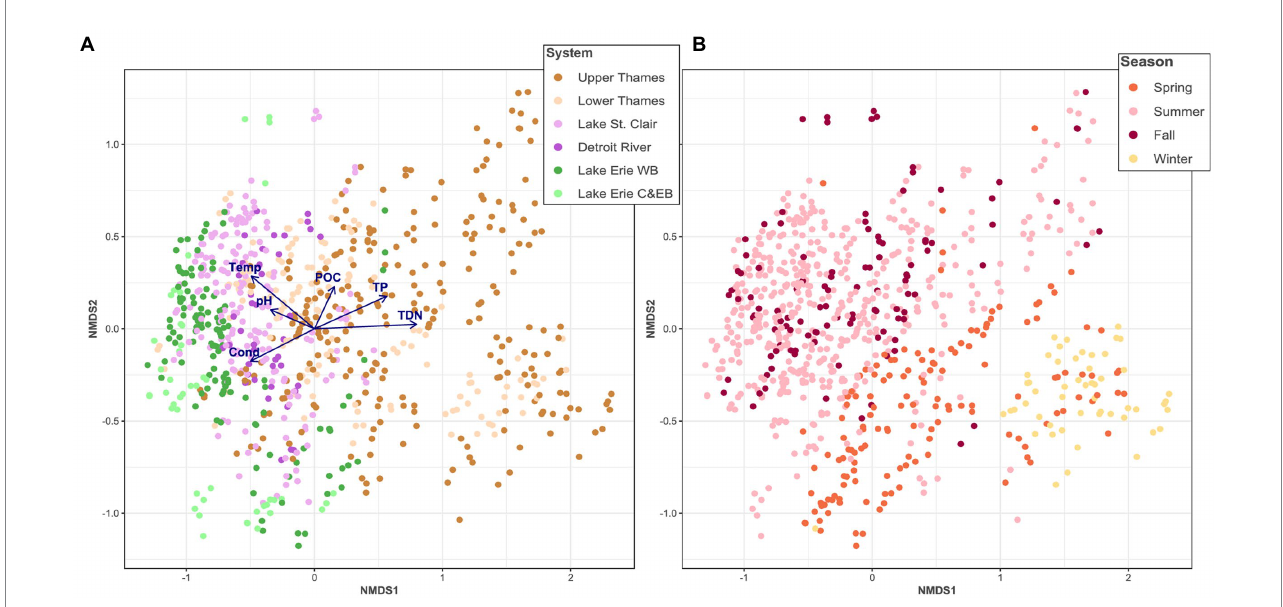
FIGURE 2 Non-metric multidimensional scaling (NMDS) of the microbial community based on Bray-Curtis distance, colored as a function of the system sampled overlaid with the significantly correlated environmental variables (A) and colored as a function of the season (B) . WB stands for Western Basin and C&EB for Central and Eastern Basin, respectively.